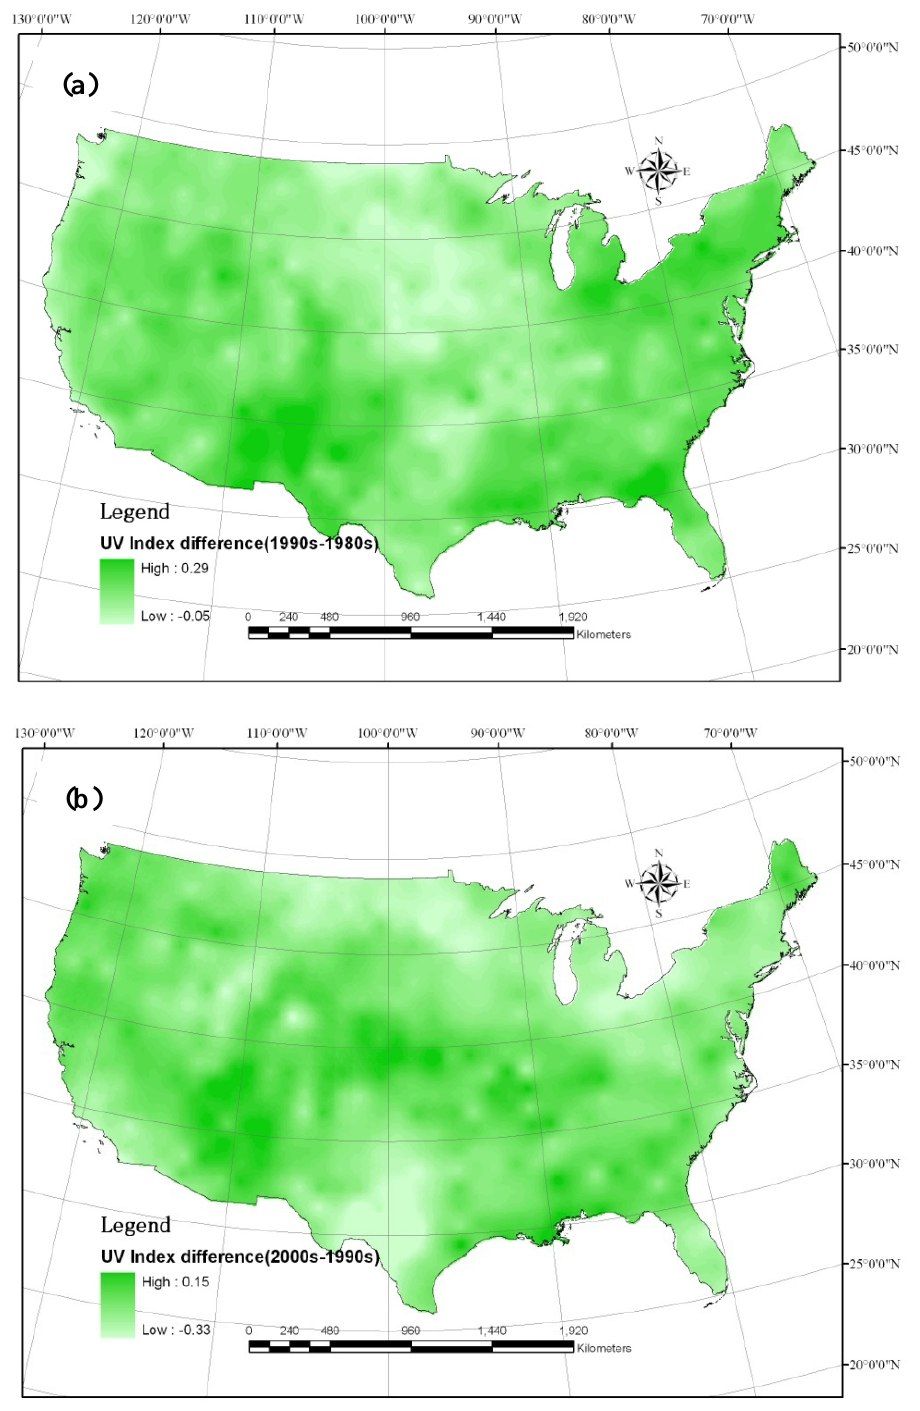
Figure 4. Multi-year spatial variation of UVI changes in the continental USA. (a) UVI difference between 1980s and 1990s; (b) UVI difference between 1990s and